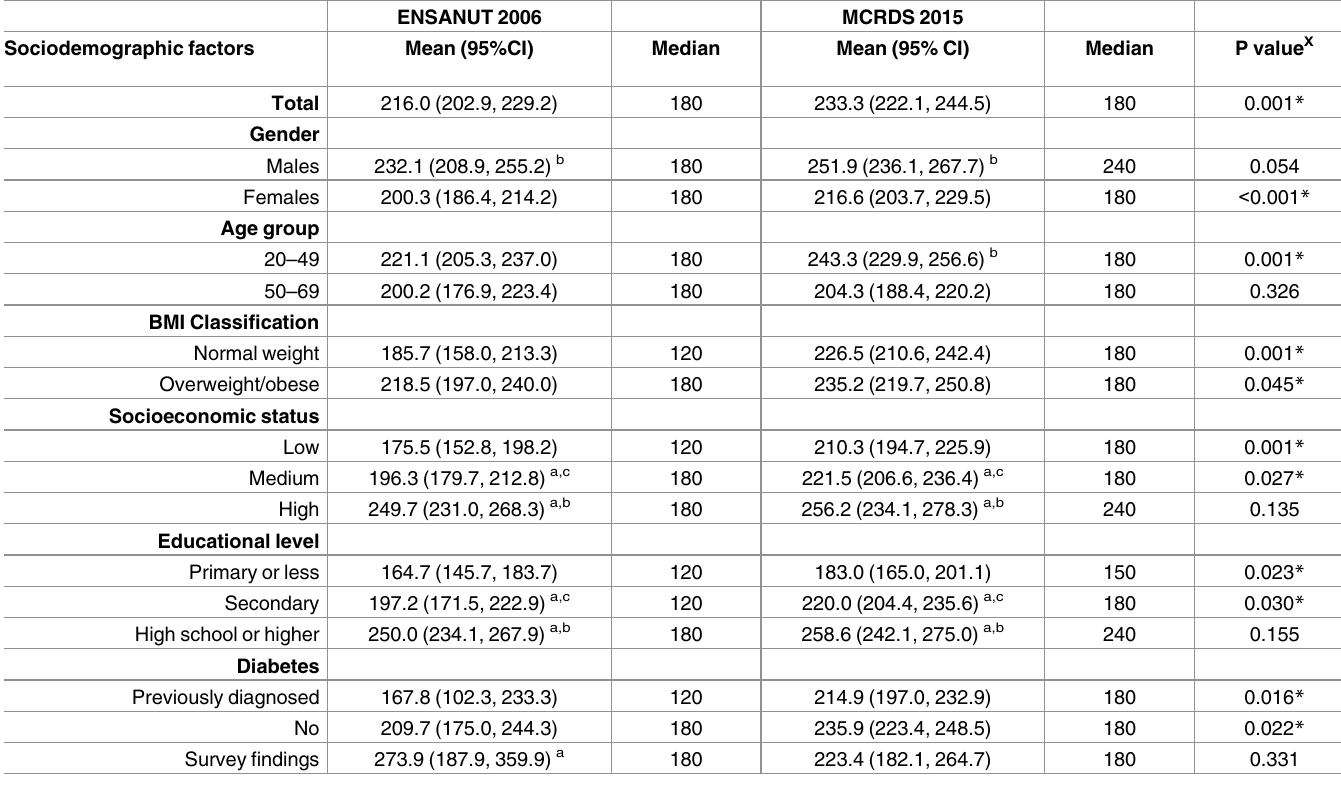
X Log-transformed p trend (2006 vs. 2015). ♦ ENSANUT: Mexican Nutrition and Health Survey 2006, MCDRS: Mexico City Diabetes Representative Survey 2015. a,b,c Different superscripted letters represent log-transformed statistically significant differences between categories (p < 0.05). * Statistically significant differences between 2006 and